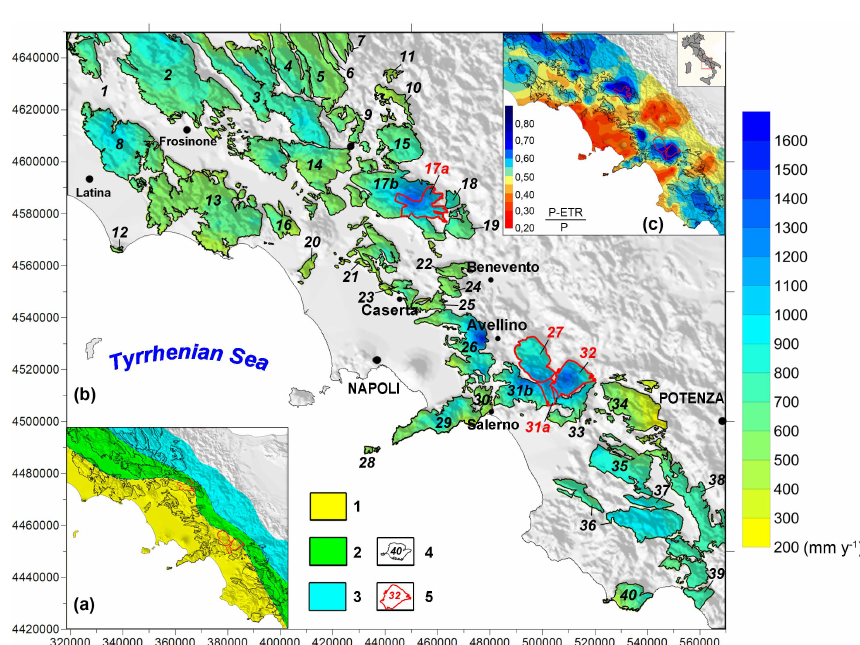
Fig. 6. Homogeneous precipitation zones (a) , distributed model of mean annual P − ETR (b) and of mean annual ( P − ETR) /P ratio (c) . Key to symbol: (1) upwind zone; (2) first downwind zone; (3) second downwind zone; (4) hydrogeological boundaries and identification number of the karst aquifers; (5) hydrogeological boundaries and identification number of the karst aquifers considered for the hydrological